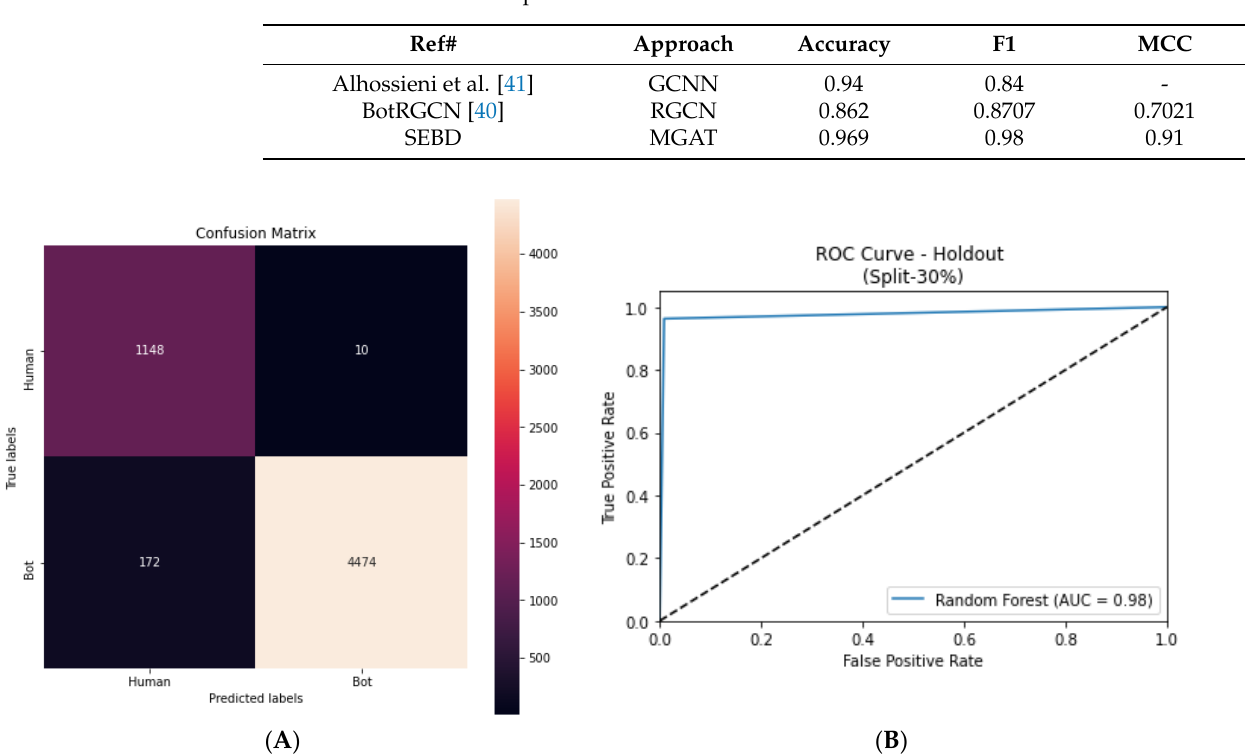
Table 3. SEBD results compared to baseline work.